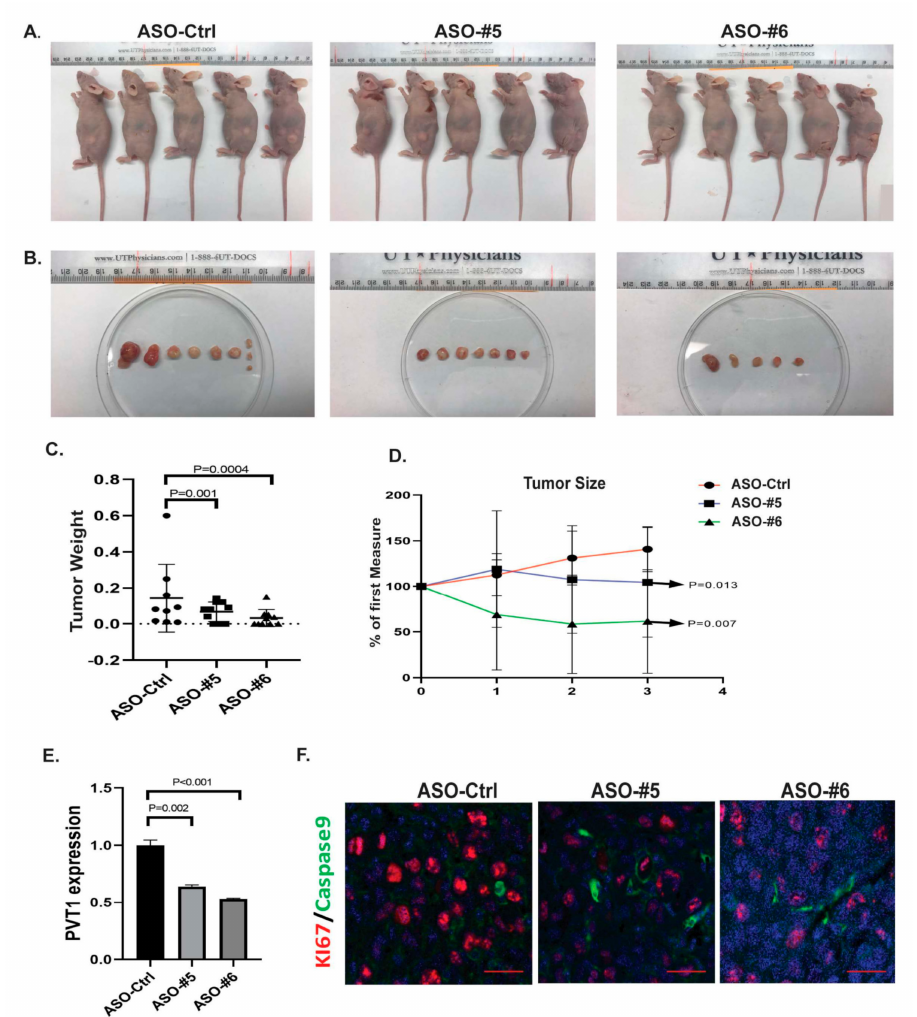
Figure 5. ASOs suppressed tumor growth in a GA0518 PDX model. ( A , B ) Mice were killed after the 3-week treatment. Tumor growth was observed and measured over 3 weeks of treatment. Representative mice and tumor images from ASOs-treated group and control group were demonstrated. ( C , D ) The tumor weights ( C ) and tumor volumes ( D ) of the ASO-treated group showed a significant reduction compared with those in the ASO control group. ( E ) PVT1 level was determined using q-PCR in mouse tumor tissues from PVT1 ASOs treated and control group. P value was shown in the Figure. ( F ) Immunofluorescent staining of proliferation marker KI67 and apoptotic marker Caspase 9 in PVT1 ASOs treated tumor tissues compared with ASO control tumor tissues were observed by confocal microscopy. Scale bars = 40 µ